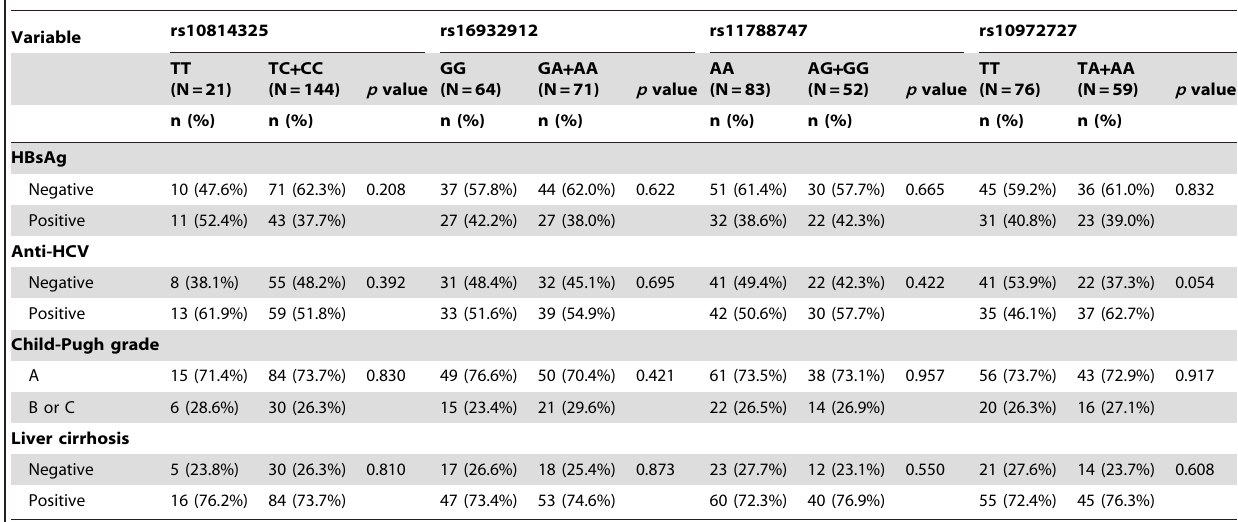
Table 5. Clinical status and RECK genotypic frequencies in 135 HCC patients.